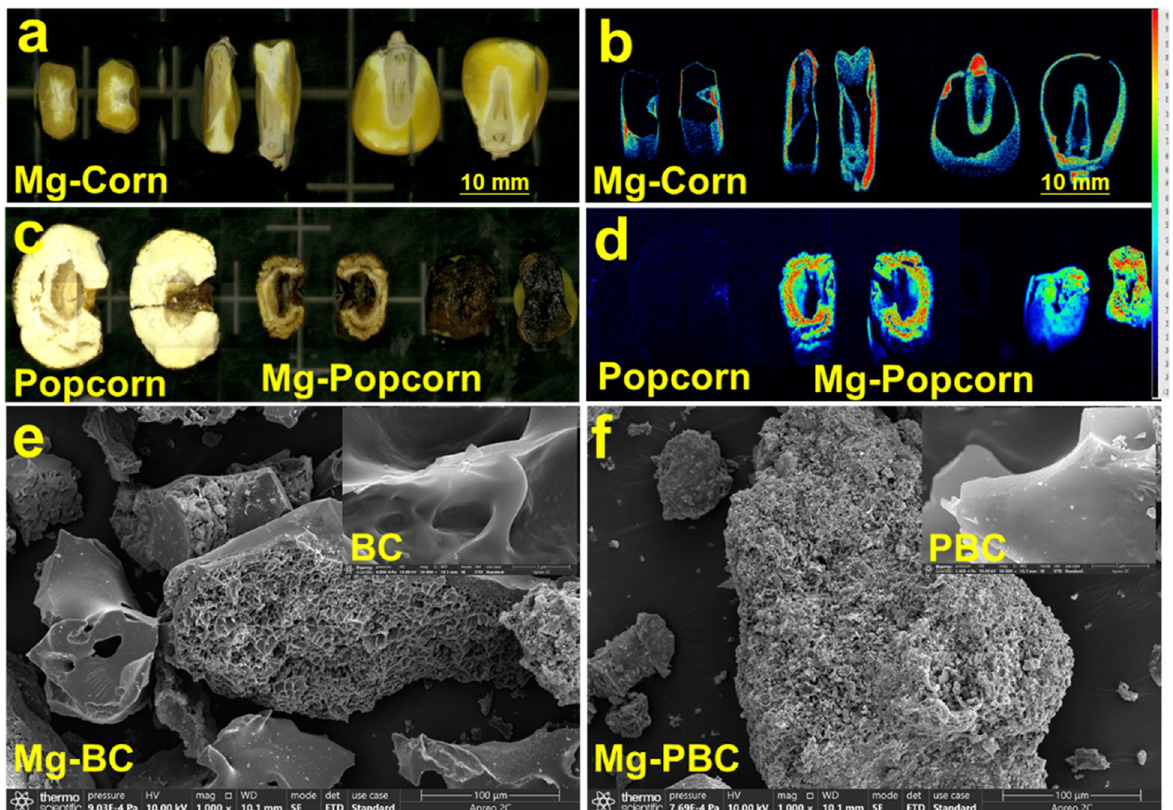
Fig. 2 μ-XRF images of corn and popcorn with or without salt solution impregnating ( a , b , c , and d ) and SEM images of Mg-BC ( e ) and Mg-PBC ( f )